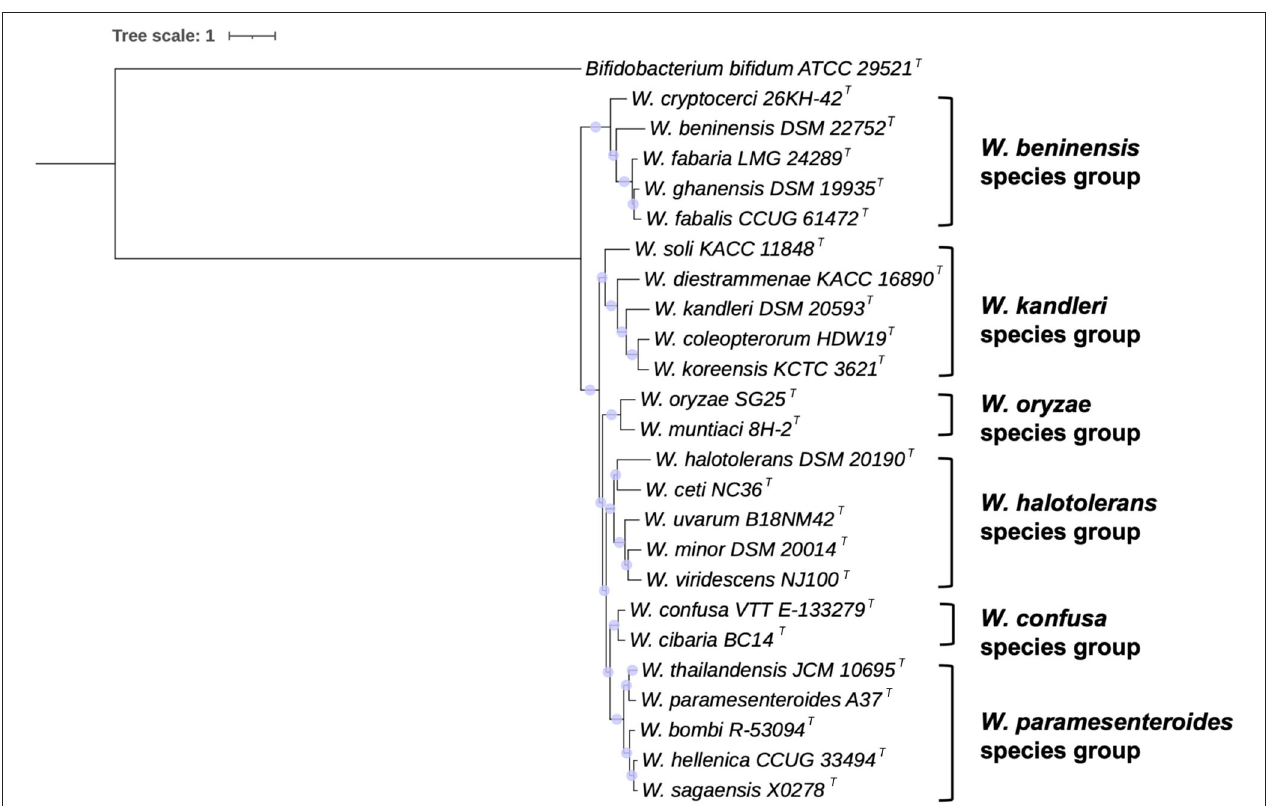
FIGURE 2 | Genome-based phylogeny of Weissella species. The tree was inferred by using the maximum likelihood method RAxML with progressive refinements. Bifidobacterium bifidum ATCC 29521 T was used as an outgroup. The tree is drawn to scale. Support values are represented by scaled circles at each node.